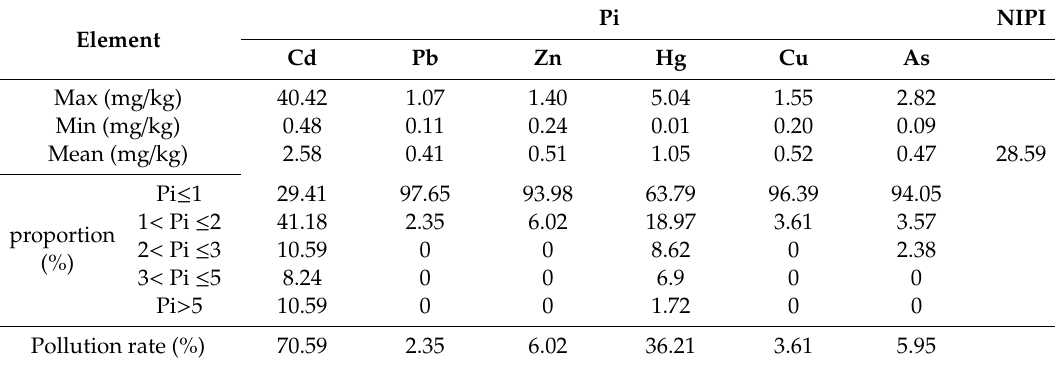
Table 3. Pollution index (PI) and Nemerow integrated pollution index (NIPI)